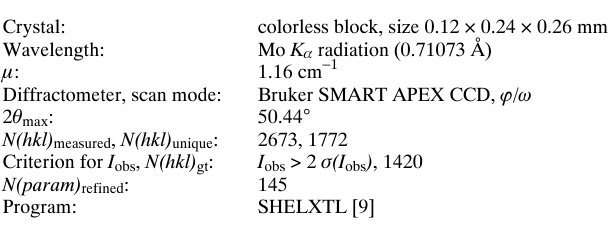
Table 1. D a t a collection a nd h a ndling.